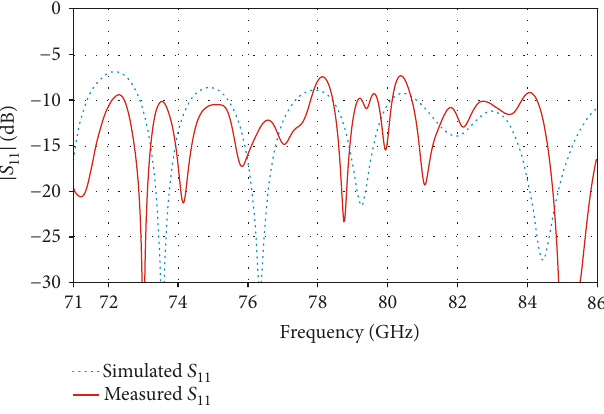
Figure 11: Measured and simulated S